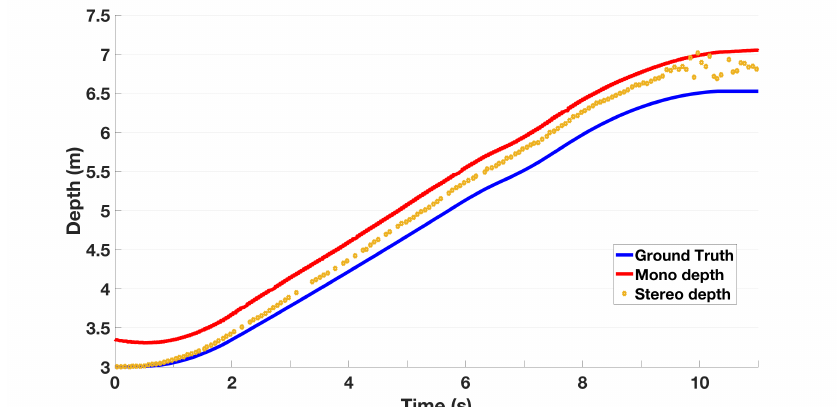
Figure 10. Depth estimation results for the stereo vision (amber) and motion parallax (red) approaches in the case of a head-on point feature when the LOS angle is between 5 and 15 ◦ . The ground truth is shown by the blue line. The camera resolution is set to